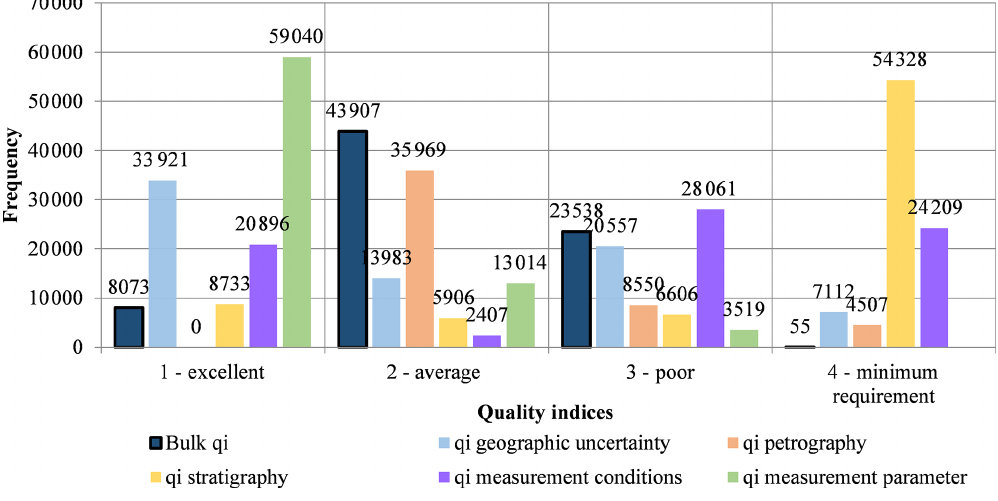
Figure 6. Overview of the quality indices (qi) distribution of the P 3 input data quality assessment. For the definition of the quality indices see Table